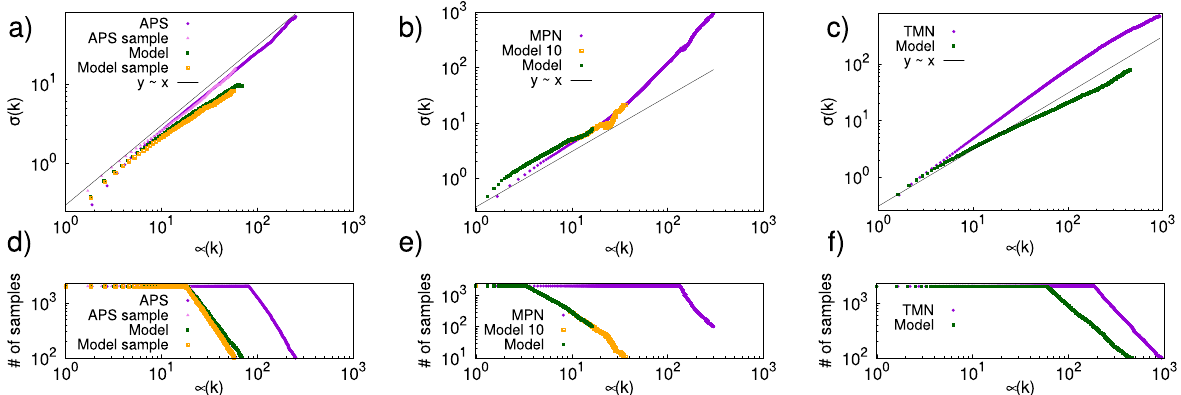
Fig. 2 Taylor ’ s law in social networks. a – c Taylor ’ s law for the number of links created by different individuals at each user ’ s intrinsic time u , being u the (cid:4) number of events where a user took part. We de fi ned μ ð k Þ (cid:3) k i ð u Þ u and where we implicitly have a dependence on the node i ’ s intrinsic time u . Results in the empirical datasets, contrasted with model predictions, for ( a ) the American physical society dataset (APS), ( b ) the mobile phone network (MPN) dataset, and ( c ) the Twitter mention network (TMN) dataset. In ( a ) we also report results for the 1-link sampled database, de fi ned in the “ Methods ” section. For all the empirical and synthetic datasets we fi nd an approximate power-law behaviour σ ( k ) ~ μ ( k ) δ , with δ ≳ 1. For each curve, we considered the 2000 individuals with the longest history ( fi nal intrinsic time). d – f We report the effective number of points over which the mean and the standard deviation is computed at each time t . This number decreases for the highest values of the mean, corresponding to higher values of intrinsic time since the number of the total performed actions varies from individual to individual. The number of samples used is reported, both for the empirical and synthetic datasets, for ( d ) the APS dataset, ( e ) the MPN dataset, and ( f ) the TMN dataset. In all the cases, we considered only averages on at least 100 samples, but for the MPN case, where we additionally show values for times where at least 10 samples were available (model 10